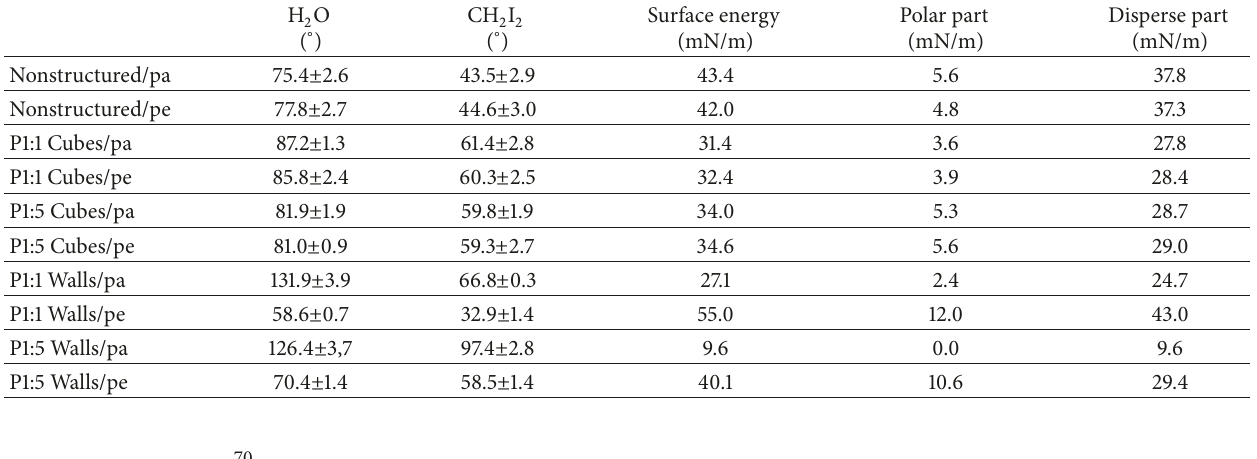
Table 1: Contact angles and calculated surface energy values for structured and nonstructured (control) surfaces (pe: perpendicular, pa: parallel).